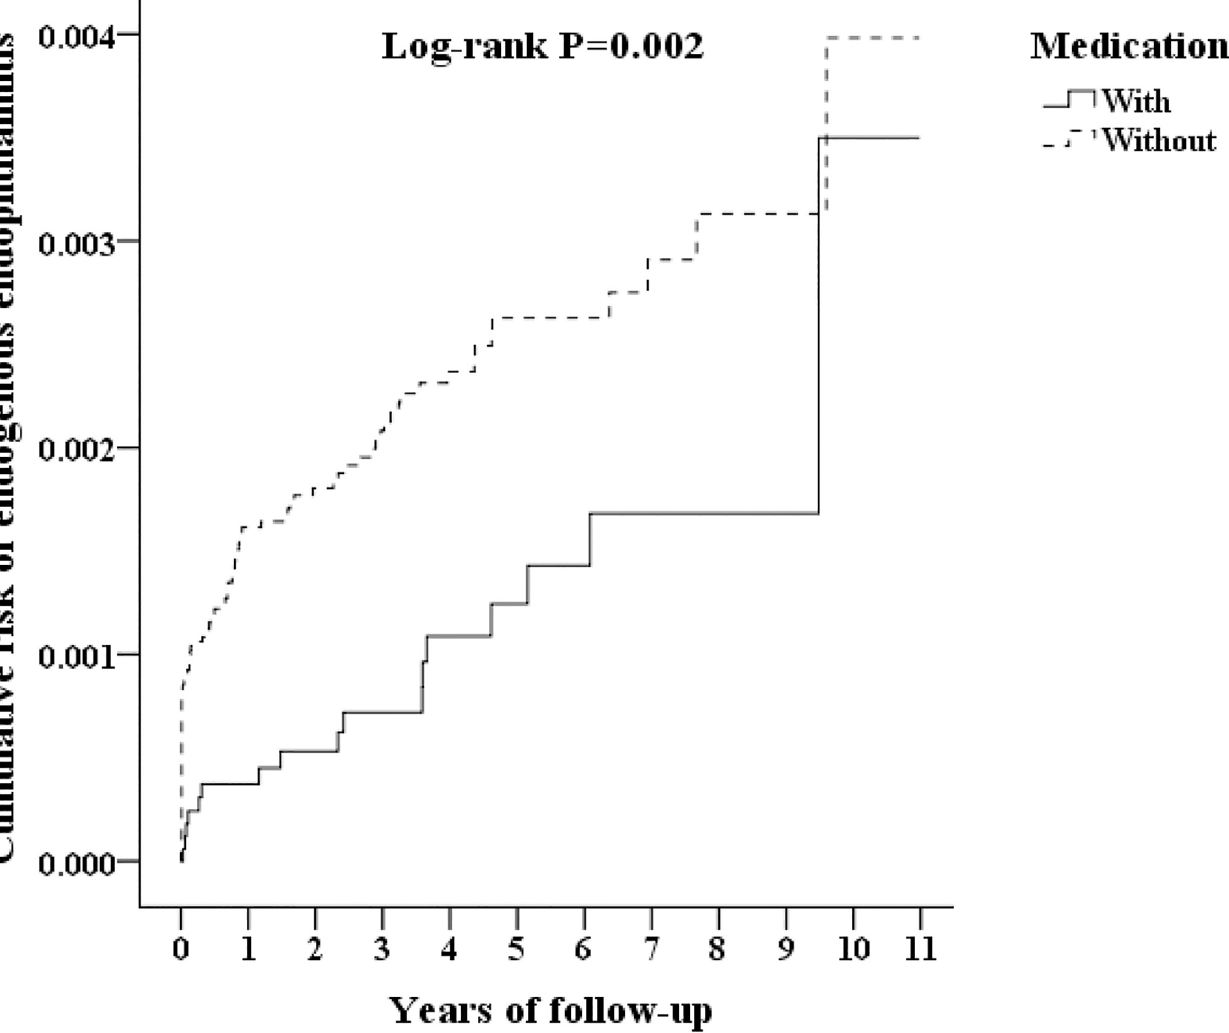
Fig 2. Kaplan-Meier curve for the cumulative incidence of endogenous endophthalmitis among patients aged 18 and stratified by medication use with the log-rank test.